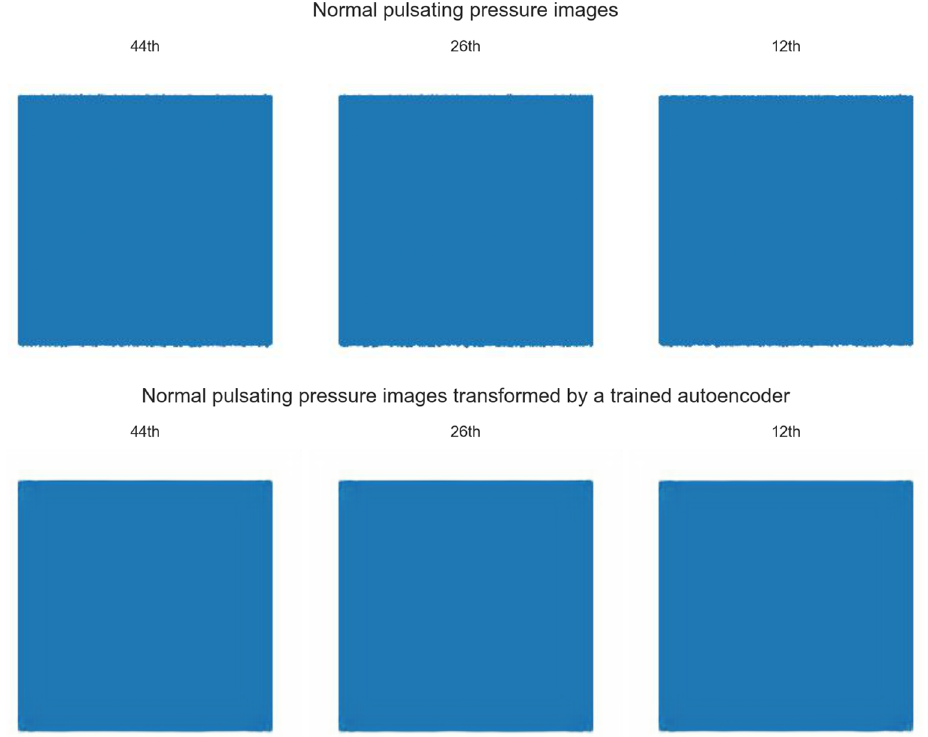
Figure 9. Normal pulsating pressure images and transformed images.